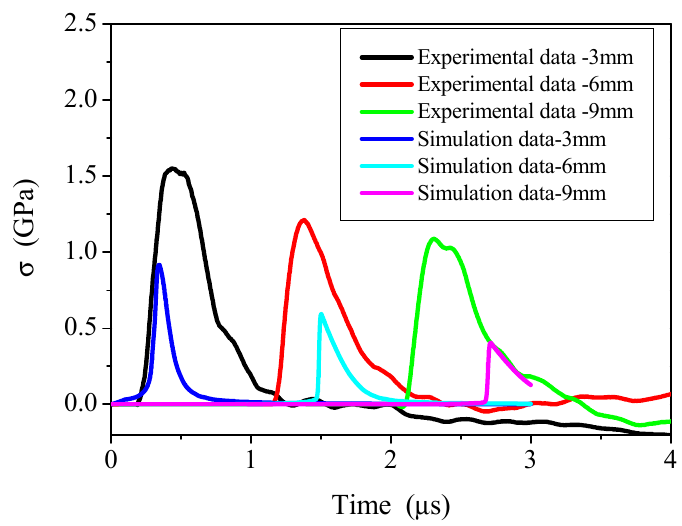
Figure 4. The measured peak stress of thermal shock wave and fitted peak attenuation curve.